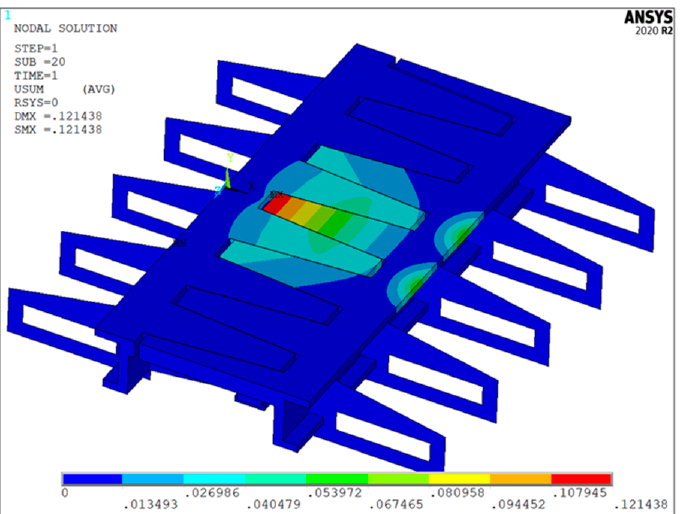
Figure 8. Maximum total deformation diagram of the structure under the working condition I.